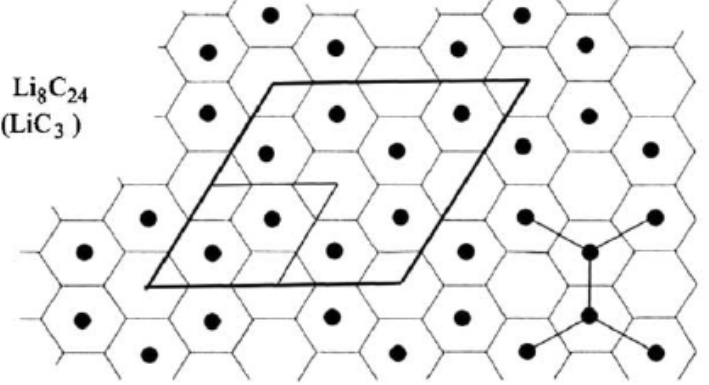
Figure 6. Schematic representation of the structure of a superdense lithium graphite intercalation compound LiC 3 , assigned through a combined X-ray powder diffraction, solid-state lithium NMR, and XPS study.